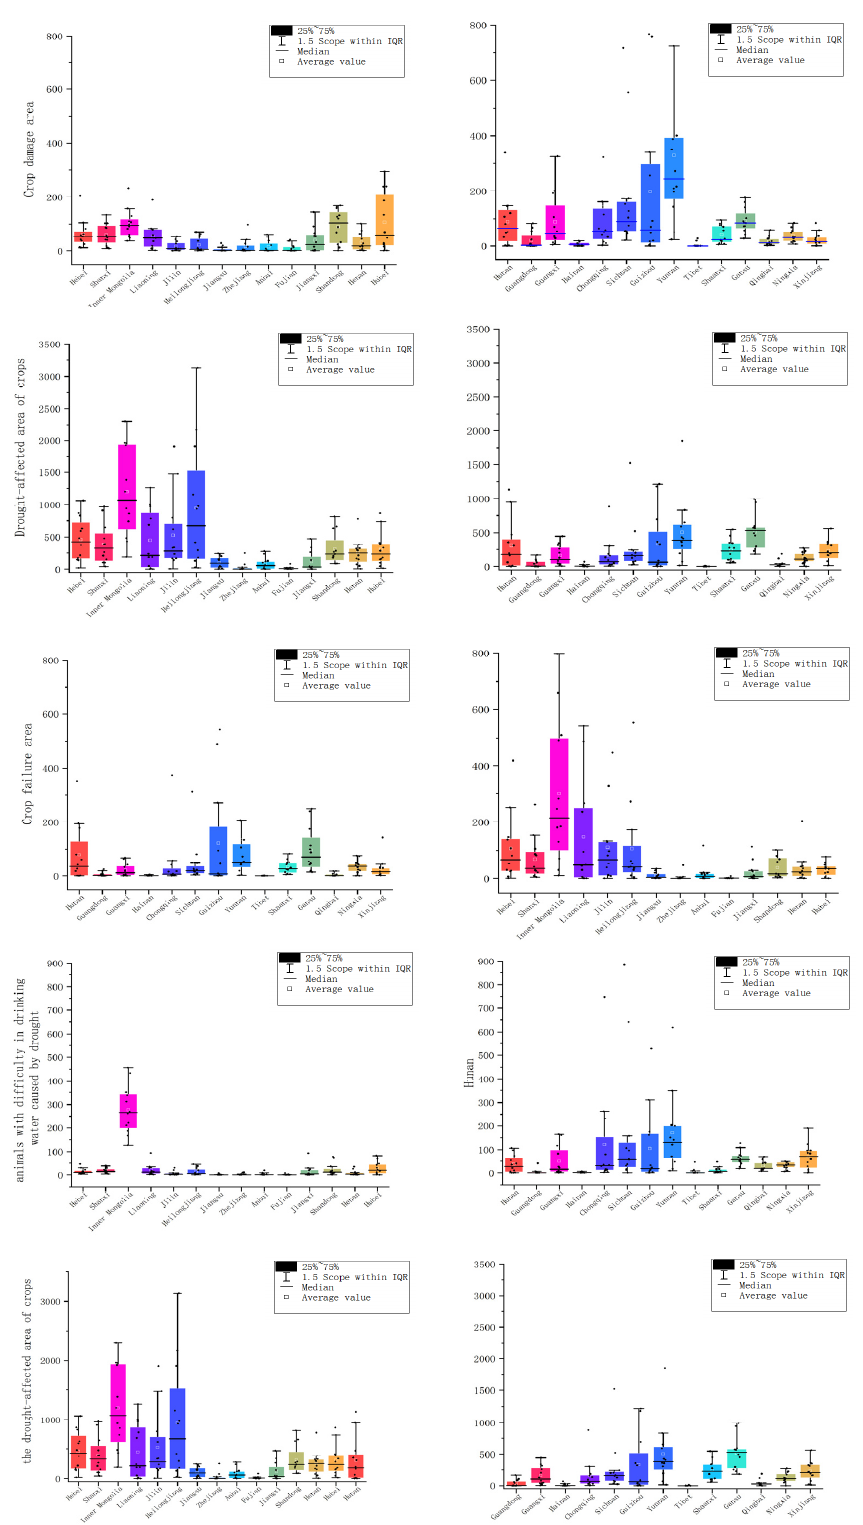
Figure 3. Drought distribution map of the provinces over the last 20 years. In Figure 4a,b, the average drought data for each province in China are shown, with six different colours indicating different grades. The darkest colour indicates the most severe level of drought and the lightest colour indicates the lightest level of